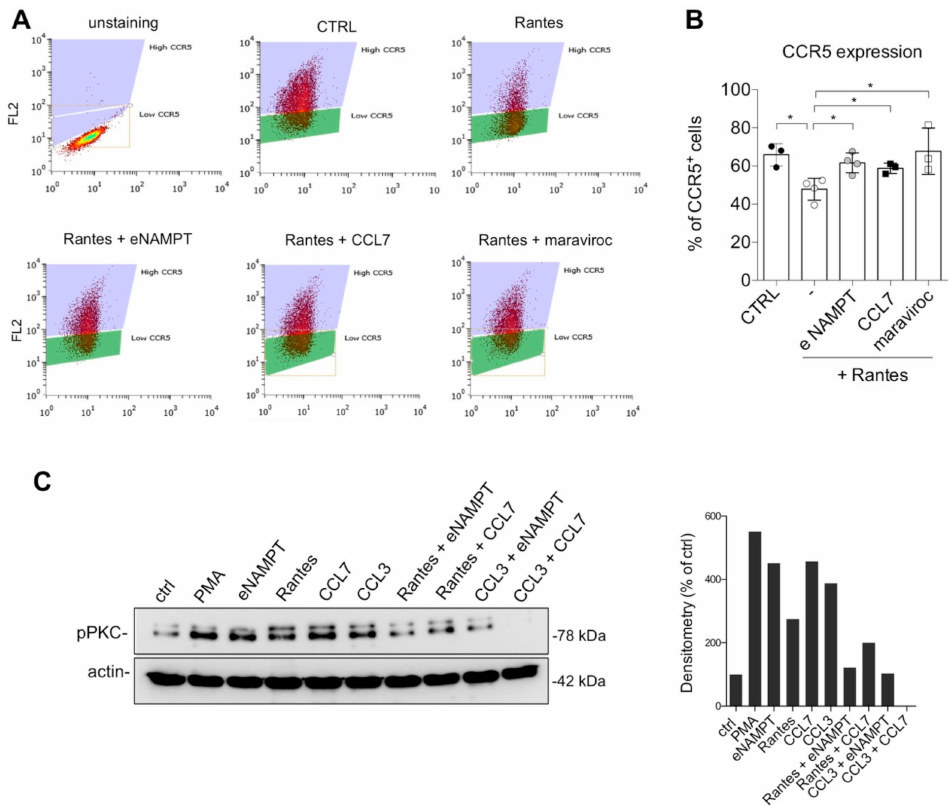
Figure 3. eNAMPT reduces CCR5 internalization and prevents pPKC activation. ( A ) Representative flow cytometry analysis of CCR5 expression in HeLa-CCR5 cells after the indicated stimuli. ( B ) Flow cytometry analysis of surface expression of CCR5 in HeLa-CCR5 cells treated for 1 h with Rantes (100 ng / mL; 12 nM) alone or pretreated for 20 min with eNAMPT (2.5 µ g / mL; 45 nM) or CCL7 (250 ng / mL; 22 nM) or maraviroc (10 µ M). Mean ± S.E.M. of four separate experiments. * p < 0.05. ( C ) Representative Western blot and densitometry of two independent experiments of phosphoPKC (pPKC) in Hela-CCR5 cells treated in serum-free for 20 min with Rantes (25 ng / mL; 3 nM), eNAMPT (500 ng / mL; 9 nM), CCL7 (250 ng / mL; 22 nM), or CCL3 (100 ng / mL; 9.9 nM) alone or